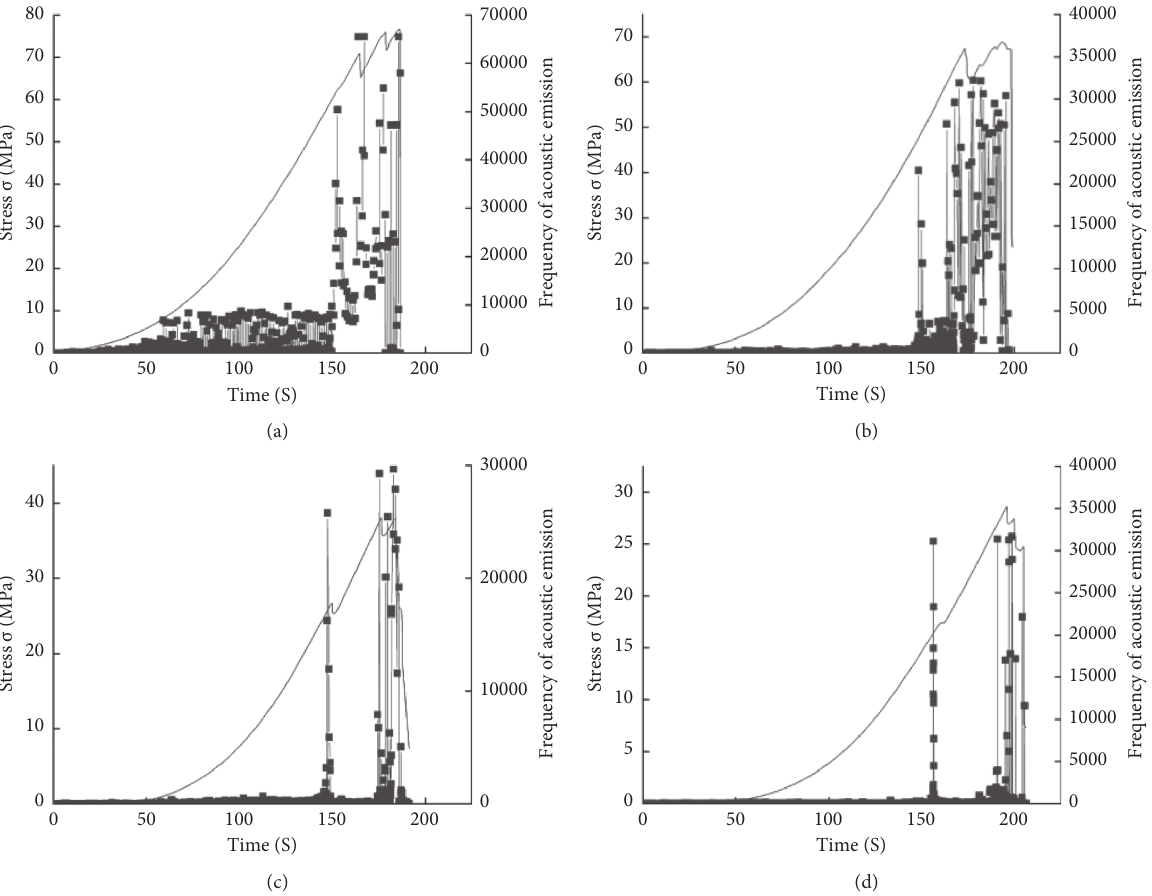
Figure 9: Stress-time-acoustic emission information of the rock sample with the horizontal hole of different diameters. (a) Stress- N -time of rock A00. (b) Stress- N -time of rock B05. (c) Stress- N -time of rock C10. (d) Stress- N -time of rock D10.